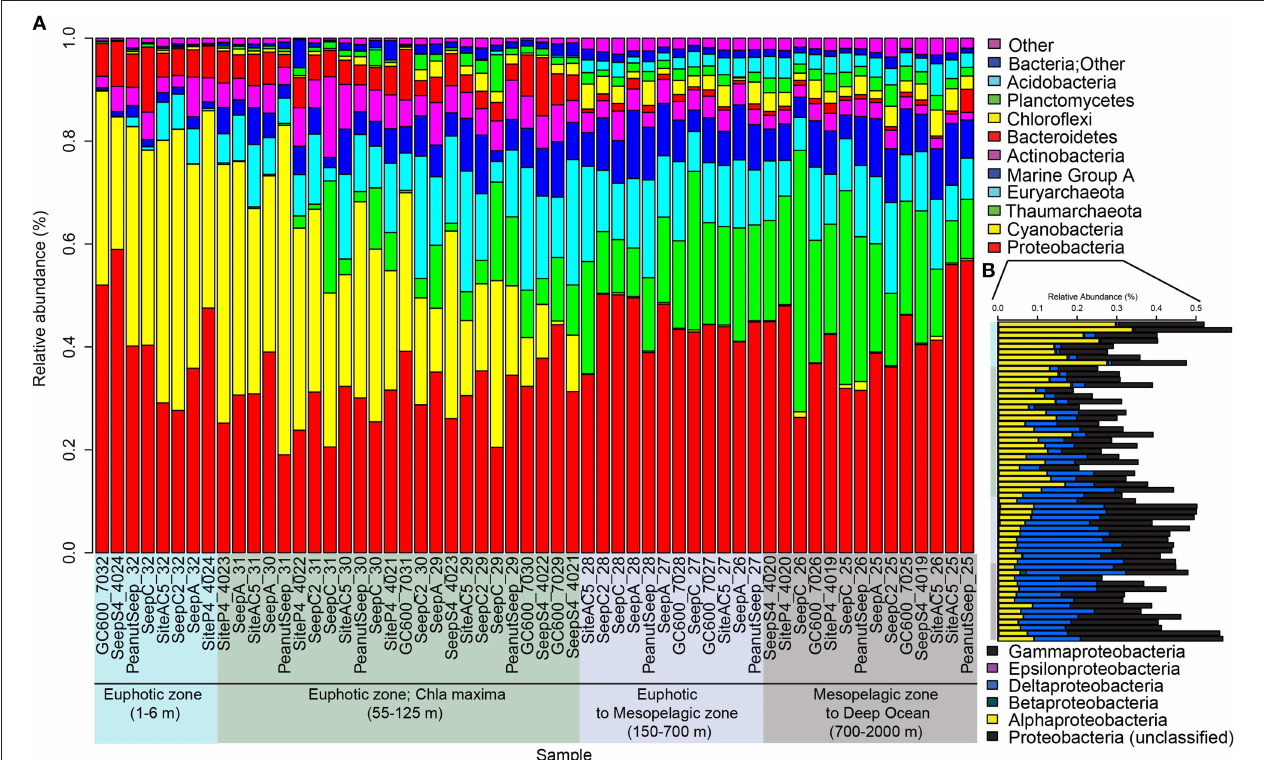
FIGURE 4 | Bar graphs of relativized 16S rRNA gene iTag sequence data. Graph (A) shows phyla level microbial community composition. Only the more abundant bacterial and archaeal groups are shown. Less abundant groups were summed under “Other.” Graph (B) shows the relative abundances of sub-phyla in the Proteobacteria. Samples are sorted by depth on the x-axis in both (A,B) . Graph (B) shows the sample depths using the same color scheme shown in (A) .